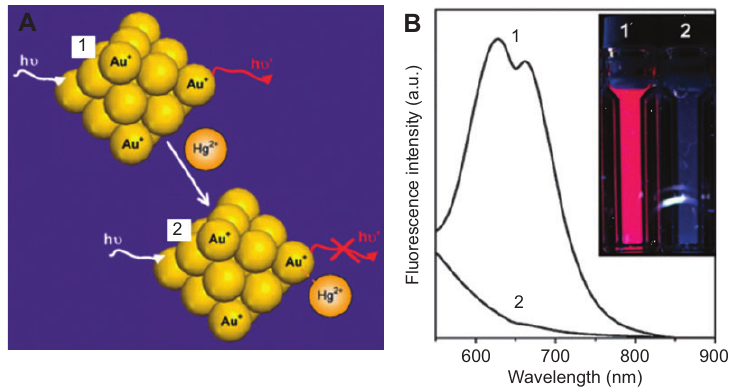
Figure 3 (A) Schematic of Hg 2 + sensing based on the fluorescence quenching of AuNCs resulting from high-affinity metallophilic Hg 2 + -Au + = 470 nm) and (inset) photographs under UV light (354 nm) of AuNCs (20 m m ) in the (1) absence and bonds. (B) Photoemission spectra ( λ ex (2) presence of Hg 2 + ions (50 m m ). From Ref. [77] .